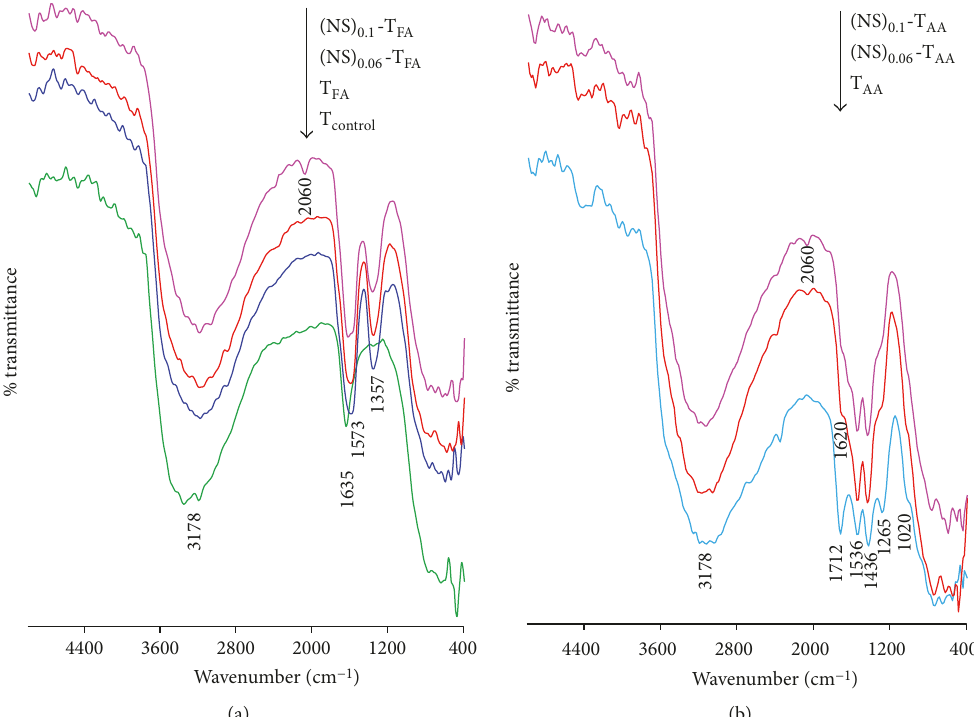
Figure 3: FTIR spectra of precalcined powders (a) T